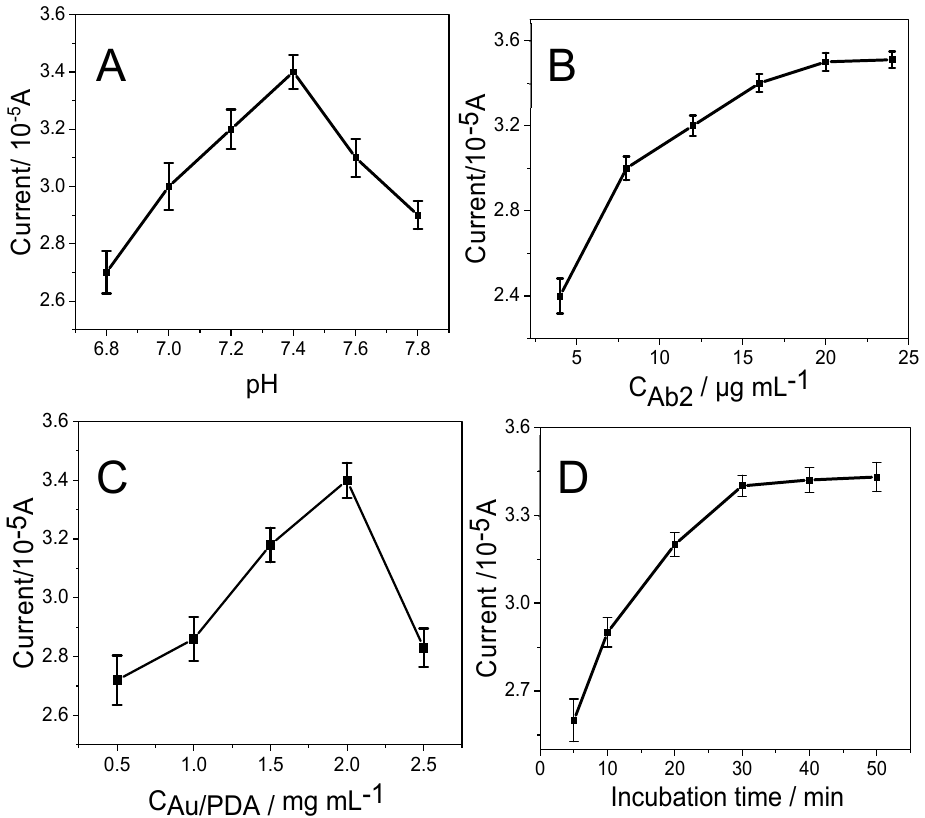
Figure 5. Effect of ( A ) pH value, ( B ) the Ab 2 /HRP-dendritic PdAuCu NPs/Fc-NH 2 -GO concentration, ( C ) Au/PDA concentration and ( D ) the incubation time on the DPV response during the detection of CEA. Error bar = RSD ( n = 5).